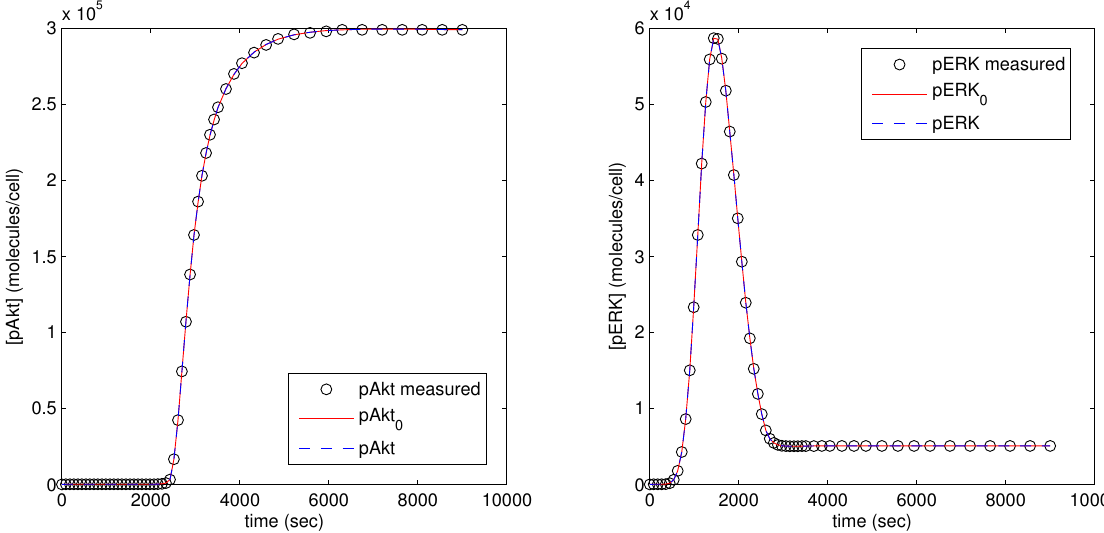
Figure 12. Results of parameter optimization with pAkt and pERK measurement as model objective. Table 1. CPU times for solution of ErbB model with hybrid and simultaneous methods. Parameters